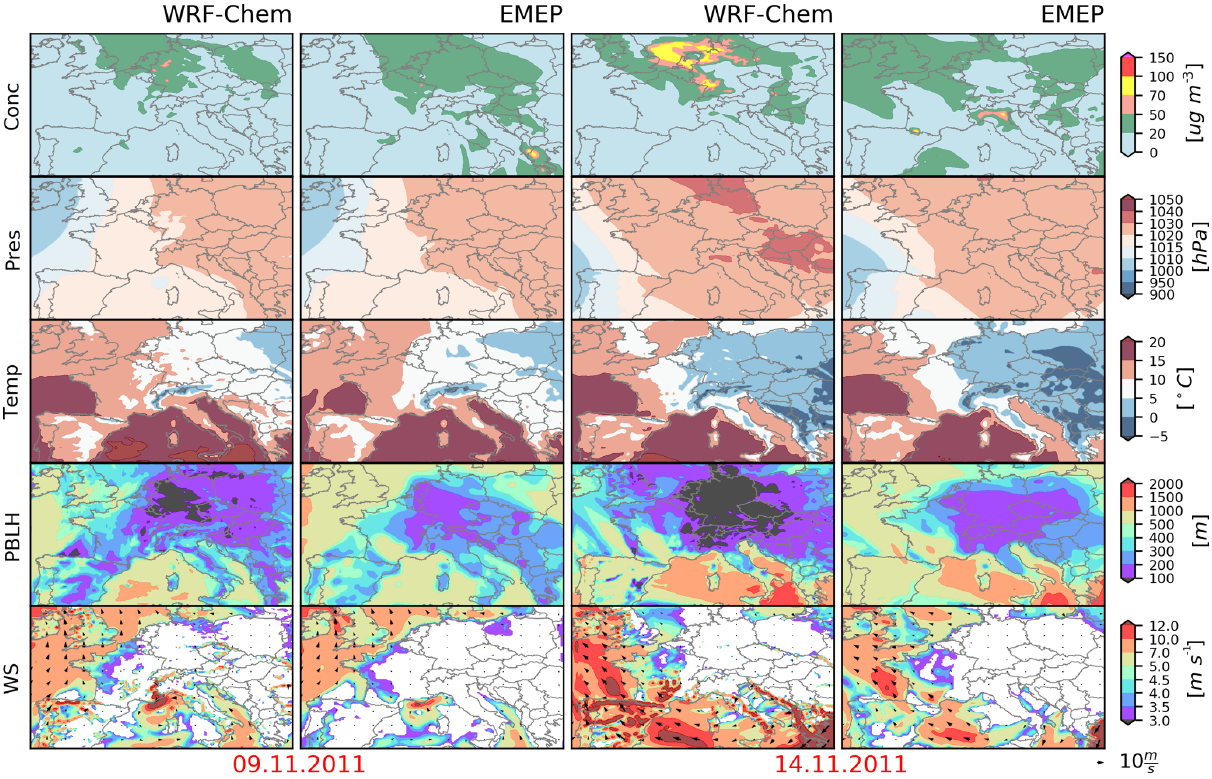
Figure 9. Modelled ( PM 10 ) d as “Conc”, and ( mslp ) d as pressure, (t 2m ) d as “Temp”, ( pblh ) d as PBLH, and ( ws ) d with ( wd ) d as WS for 2 typical days during the first (9 November 2011) and second (14 November 2011) high-pollution episodes from the WRF-Chem and EMEP